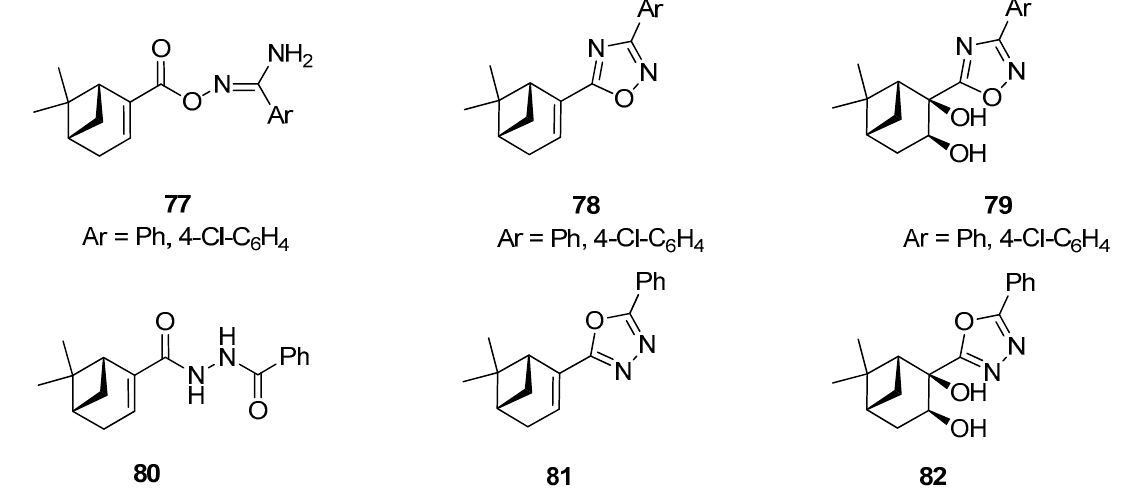
Figure 17. Monoterpene-based 1,2,4- and 1,3,4-oxadiazole derivatives.